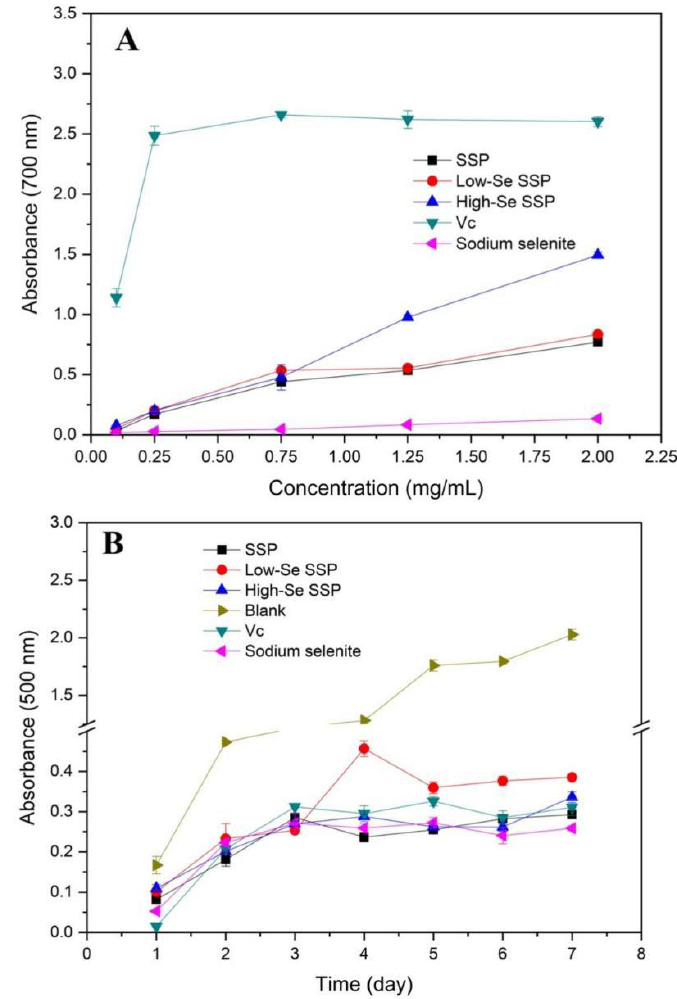
Figure 5. Reducing power ( A ) and ferric thiocyanate (FTC) test ( B ) of SSP, low-Se SSP, high-Se SSP, Vc (positive control), and sodium selenite (inorganic Se) at different concentrations. Values are means ± SDs ( n = 3).